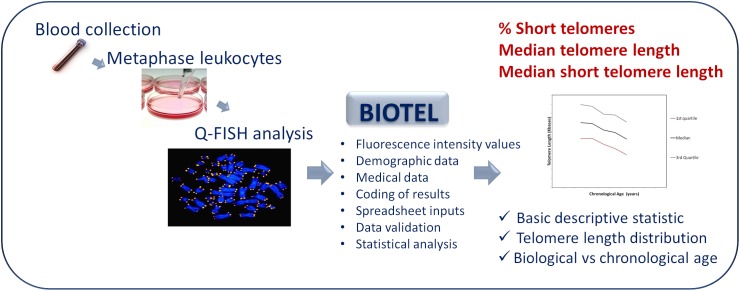
An overview diagram of the telomere estimation process. Q-Fish analysis on metaphase leukocytes, isolated from human blood was applied. BIOTEL combine the fluorescence data of leukocyte telomeres with demographic and medical data. After coding and validation of data, estimation of statistical measure and graphical representations of data were provided.